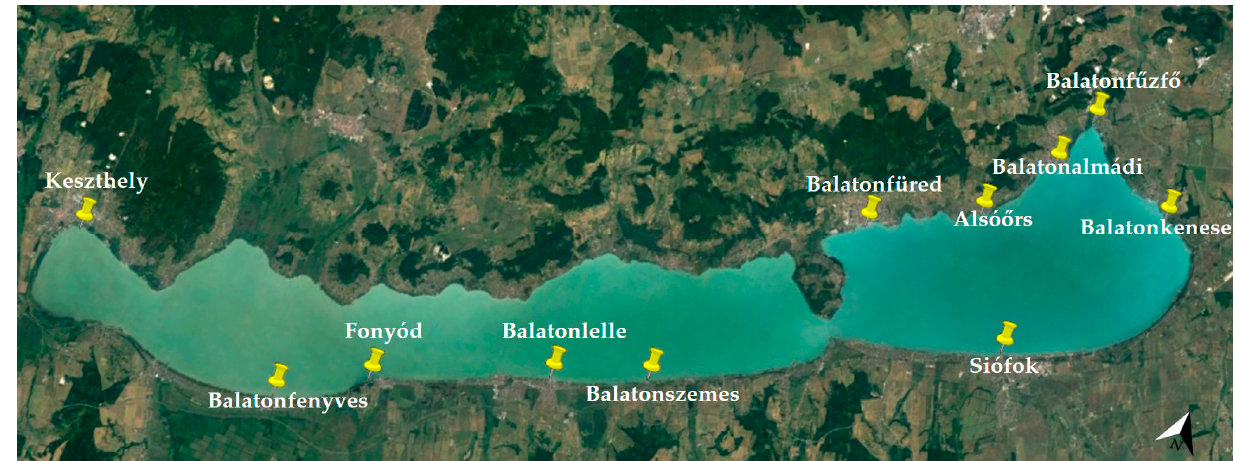
Figure 6. The 10 most significant resorts of Lake Balaton in terms of berths for sailboats, based on [55].